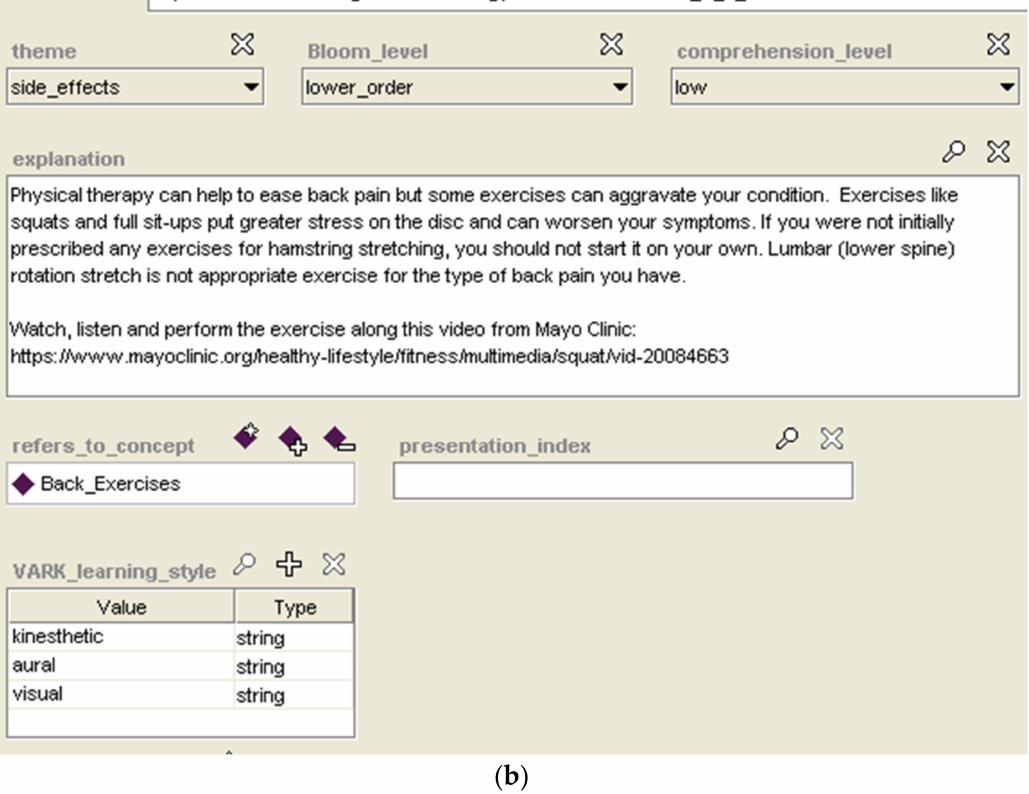
Figure 3. Examples of BUKs represented in the eLearning ontology. ( a ) A Q&A BUK related to the missed anticoagulant dosage annotated for higher-order learning; ( b ) A Content BUK related to the exercises that are not recommended for patients with back problems annotated for low comprehension